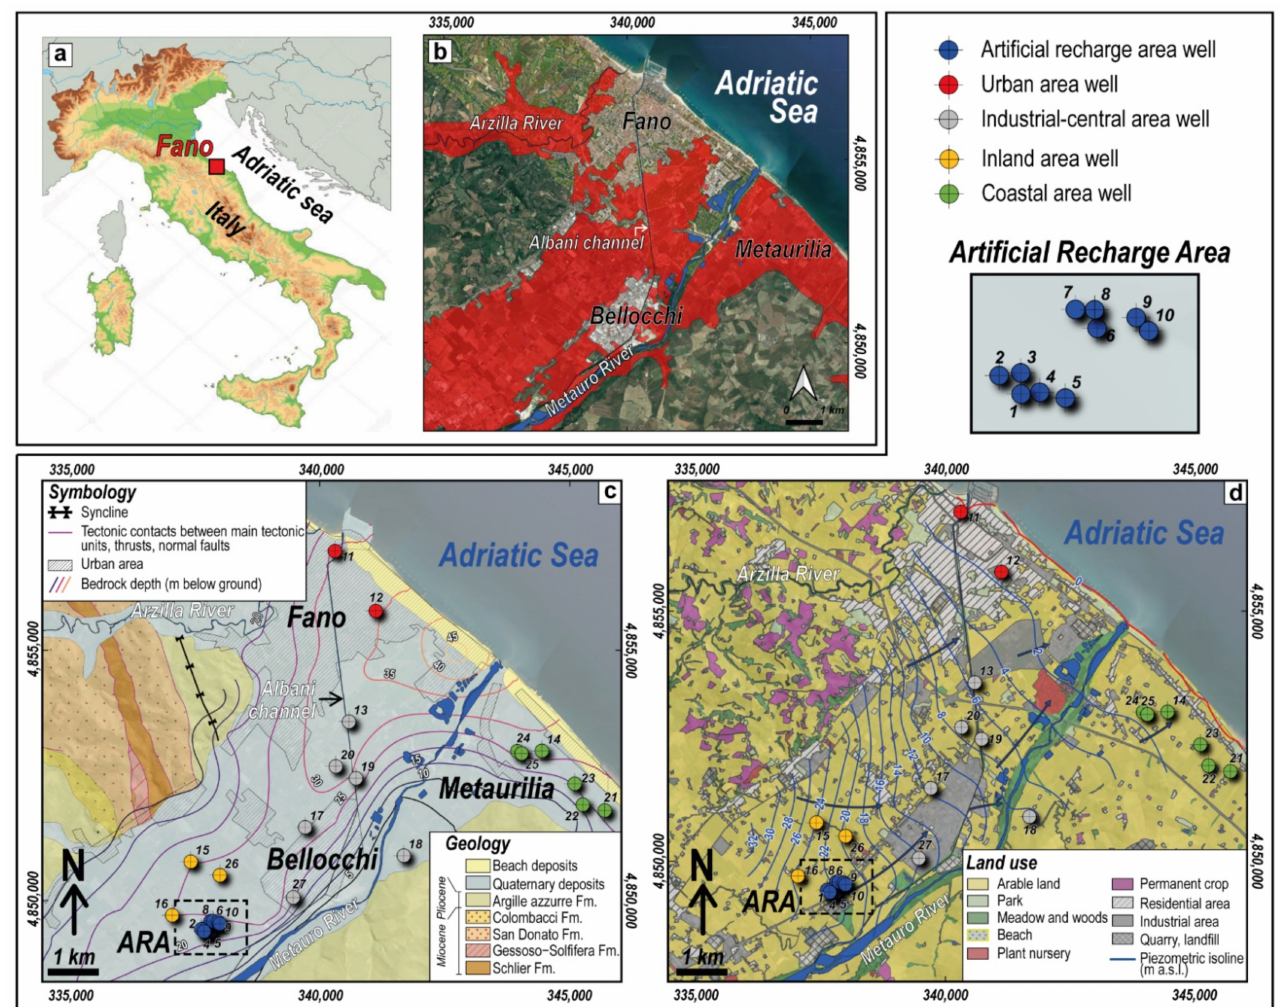
Figure 1. ( a ) General location and ( b ) map of the nitrate vulnerable zones (in red) of the study area (modified from Regione Marche [20]); ( c ) geological map (modified from Conti et al. [21]) in which the contour lines of bedrock depth are reported (after Taussi et al. [22]); ( d ) land use map (modified from Regione Marche [23]) in which the averaged piezometric isolines referred to 2019–2020 are represented (after Nisi et al. [18]). Reference system: WGS84-UTM